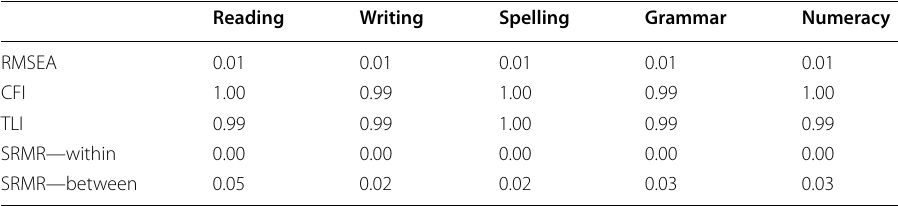
Table 3 Grade five model fit indices